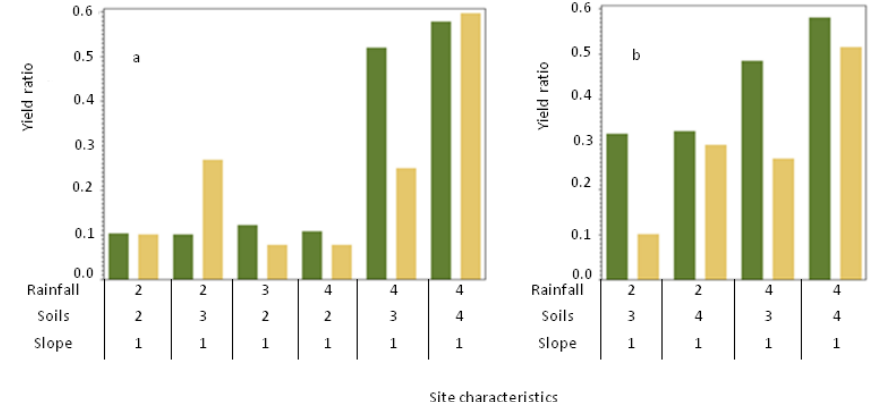
Figure 6. Comparing yields under “low” (green) and “severe” (light brown) degradation for uniform sites defined by three variables (rainfall, soil, and slope) for “low” (a) and “moderate” (b) fertilizer applications. Codes on x axis for rainfall are 1 = <200; 2 = 200–400; 3 = 400–700; 4 = >700mm; for soils 1 = unsuitable; 2 = not suitable; 3 = moderately suitable; 4 = suitable; for slope 1 = no slope; 2 =